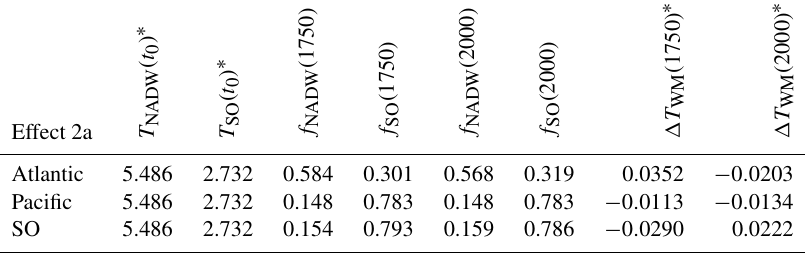
∗ Temperatures are in ◦ C.